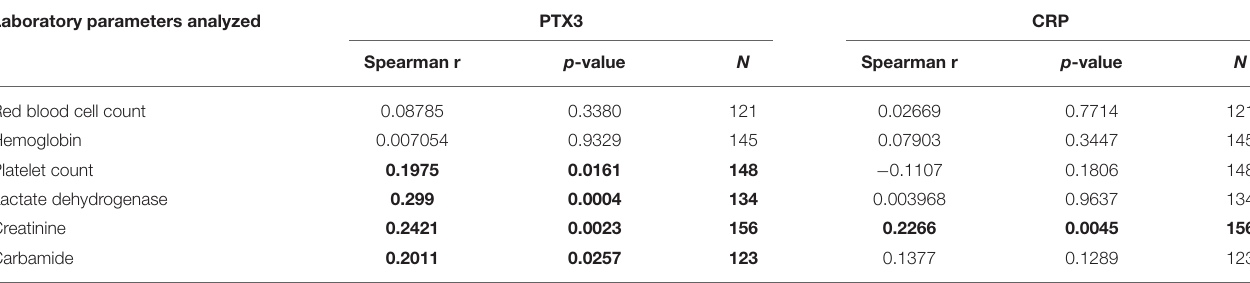
TABLE 2 | Correlation of the systemic pentraxin levels to laboratory markers of TMA. Laboratory parameters analyzed